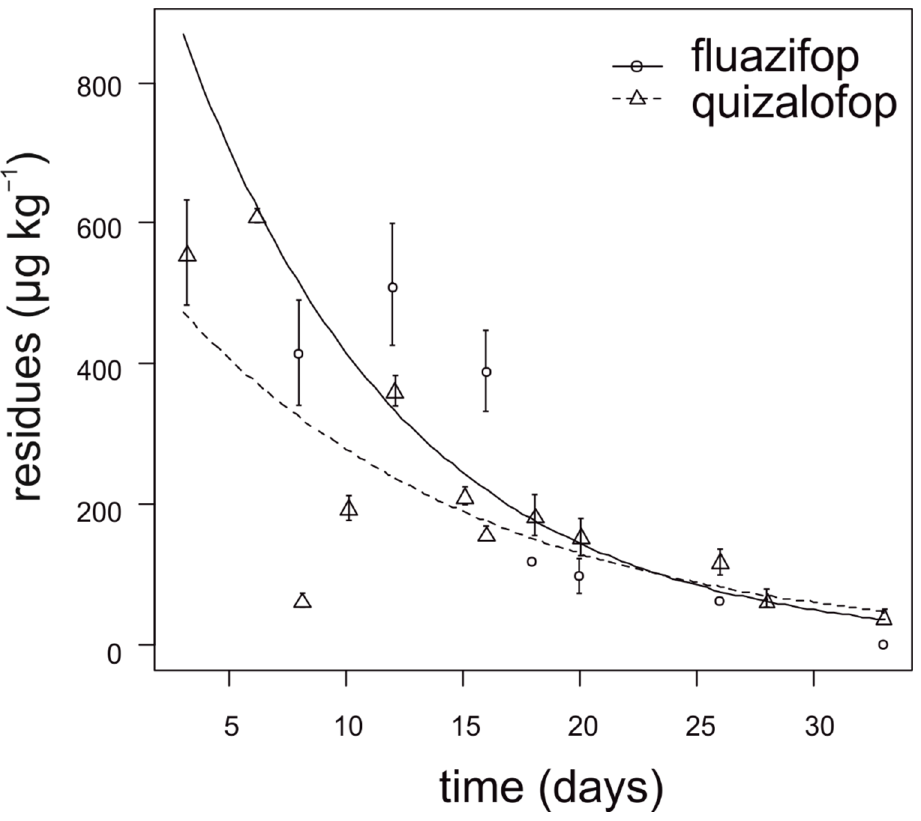
Figure 3. Degradation dynamics of fluazifop and quizalofop in lettuce. Mean values with error bars representing standard error of the mean.